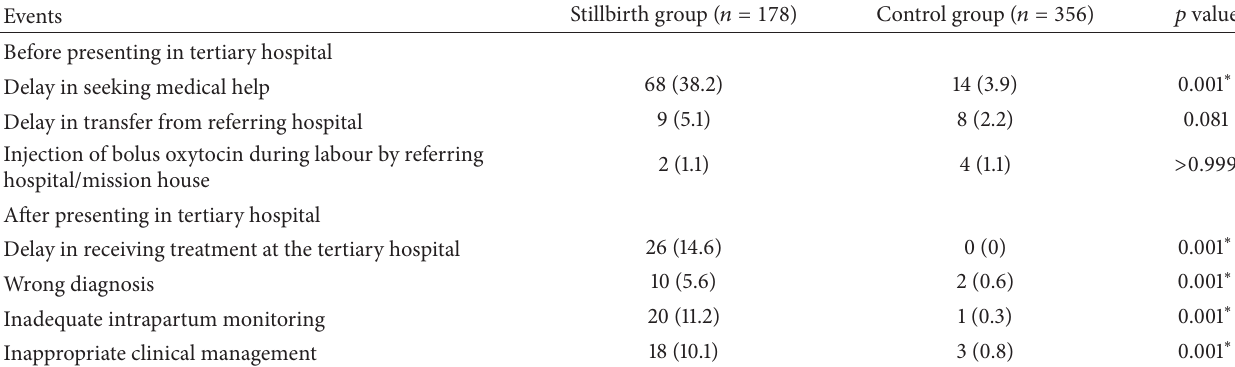
Table 3: Events potentially contributing to